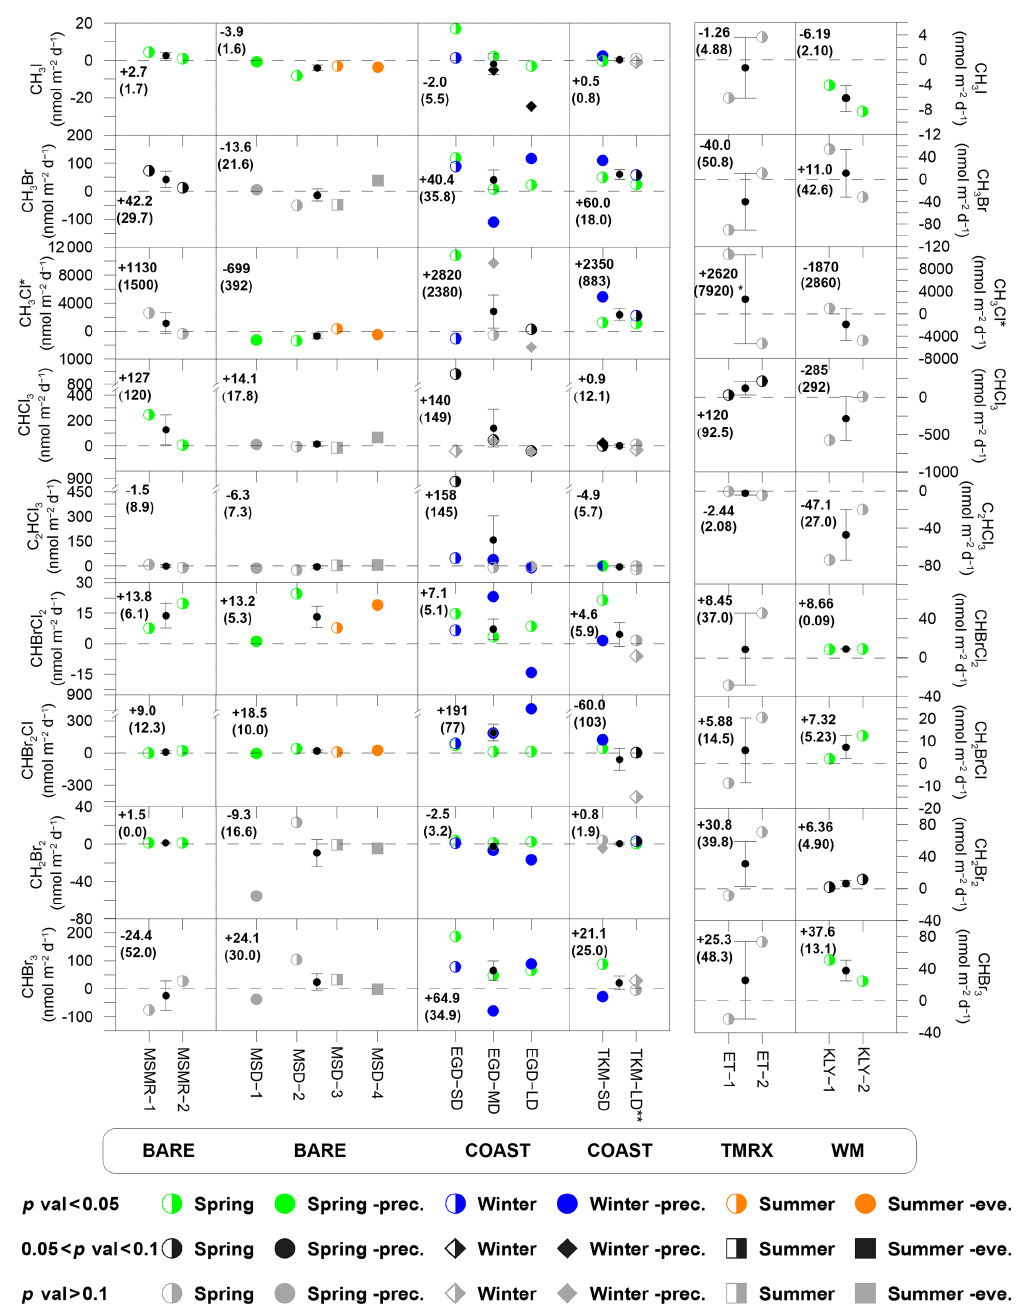
Figure 3. VHOC fluxes at the different measurement sites. Fluxes associated with p values <0.05 are marked by colored circles to indicate measurements during spring, winter and summer, with solid colored circles indicating measurements up to 3d after a rain event in spring (Spring-prec.), up to 6d after a rain event in winter (Winter-prec.) and in the evening in summer (Summer-eve.). Gray and black shapes indicate fluxes associated with no clear statistical significance ( p >0.1 and 0.05< p <0.1, respectively). At the center of each graph, the small black circles and error bars represent the average and standard error of the mean (SEM), respectively, for each measurement site. Dashed lines represent zero flux. In each box, the numbers indicate the mean flux and SEM (in parentheses) for each site and species. Additional information is provided for measurement conditions (Tables 1 and S6), measurement abbreviations (Table 1) and statistical analysis (Table 2). ∗ Calculation of CH ∗∗ Calculation of mean flux and SEM 3 Cl flux mean and SEM excludes one sample at TMRX–ET-1 (see Sect. 2.1.2). excludes one sampling canister at COAST–TKM-LD (see Sect.